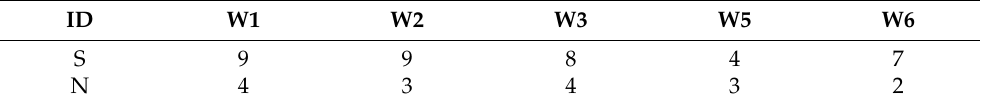
Table 3. The score and selected number of body parts for each